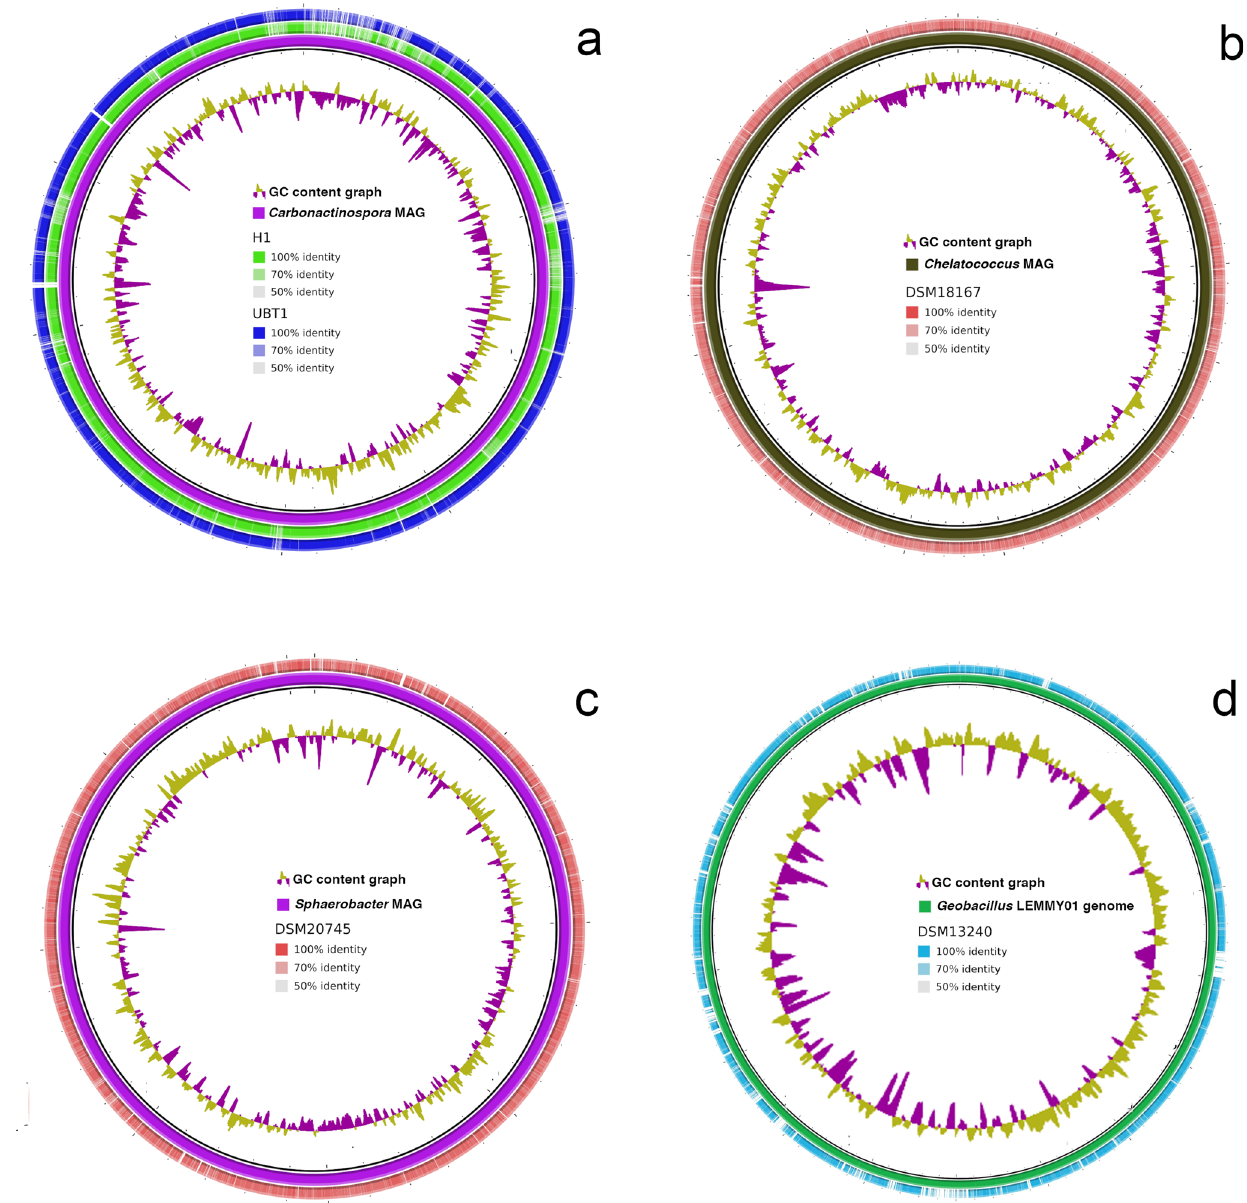
Fig. 4 Circular representation of the comparison between carbonitro fl ex MAGs and their closest reference strains. a Actinomycete isolated from the carbonitro fl ex consortium ( Carbonactinospora thermoautotrophica St_consortium) and strains UBT1 and H1; b Chelatococcus spp. consortium strain and the reference strain DMS18167; c Sphaerobacter thermophilus from the consortium and the reference strain DSM20745; and d Geobacillus spp. strain LEMMY01 and the reference strain DSM13240. More-intense colors represent higher BLASTN identities; GC content is indicated in the inner